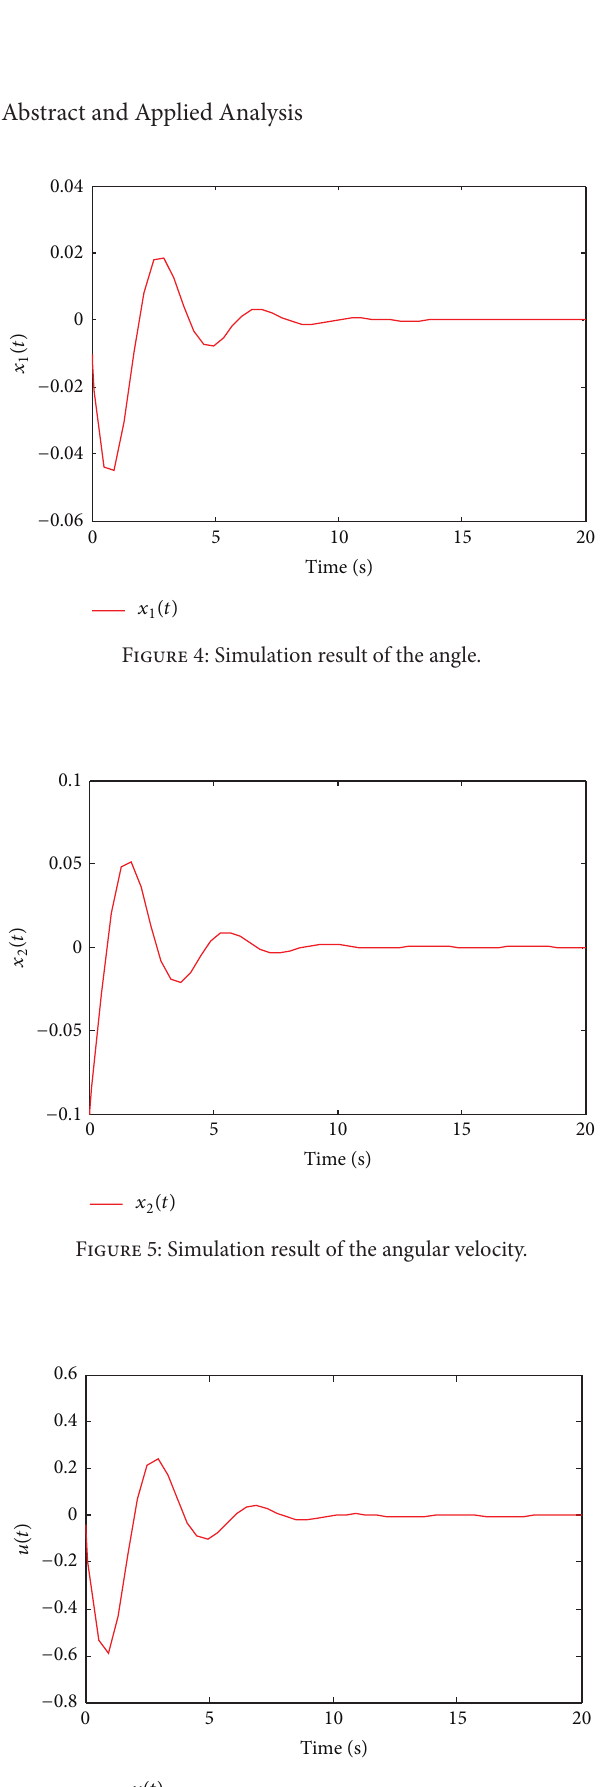
Figure 6: Simulation result of the